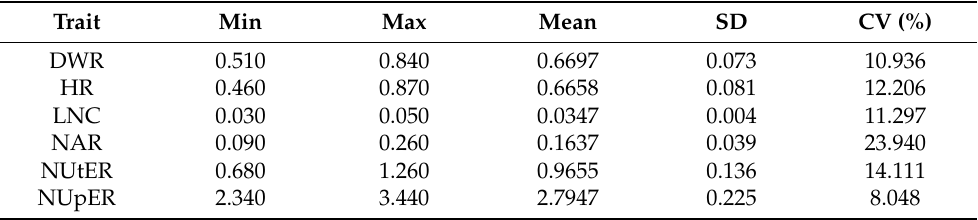
Figure 1. Genetic diversity and population structure of the studied cucumber accessions. ( a ) Phylo- genetic trees constructed based on maximum likelihood method for 88 lines. ( b ) PCA of 88 cucumber lines, where the y -axis quantifies subgroup membership, and the x -axis shows the different accessions. ( c ) Cross-validation error value of K = 2–10 in population structure analysis. ( d ) Population structure composition of 88 cucumber lines at K = 3–5. Table 1. Phenotypic variation of 88 cucumber